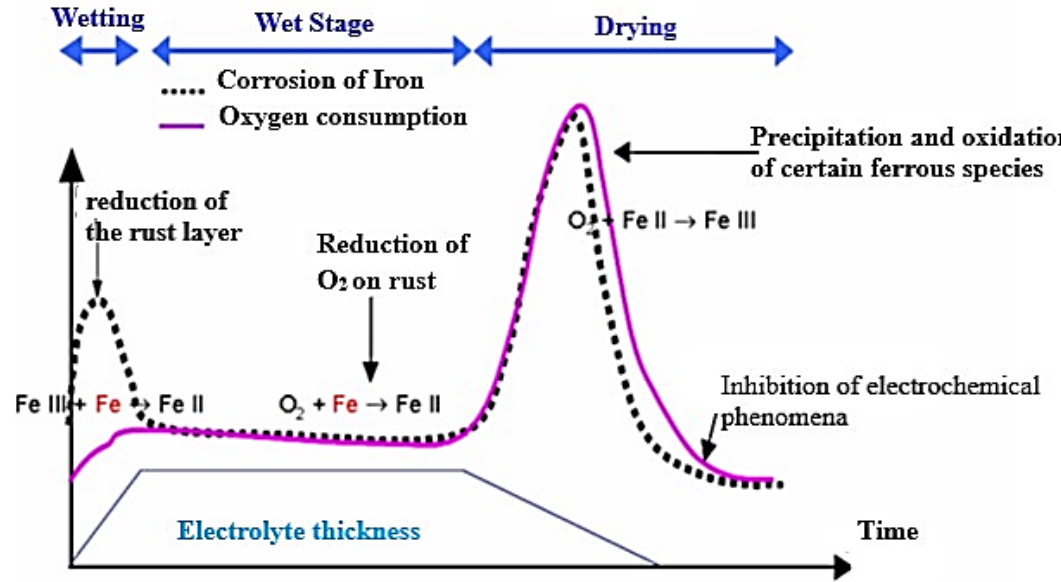
Figure 4. Stratmann humidification–drying cycle. NB: iron consumption (bold dotted line) oxygen consumption (bold solid line).